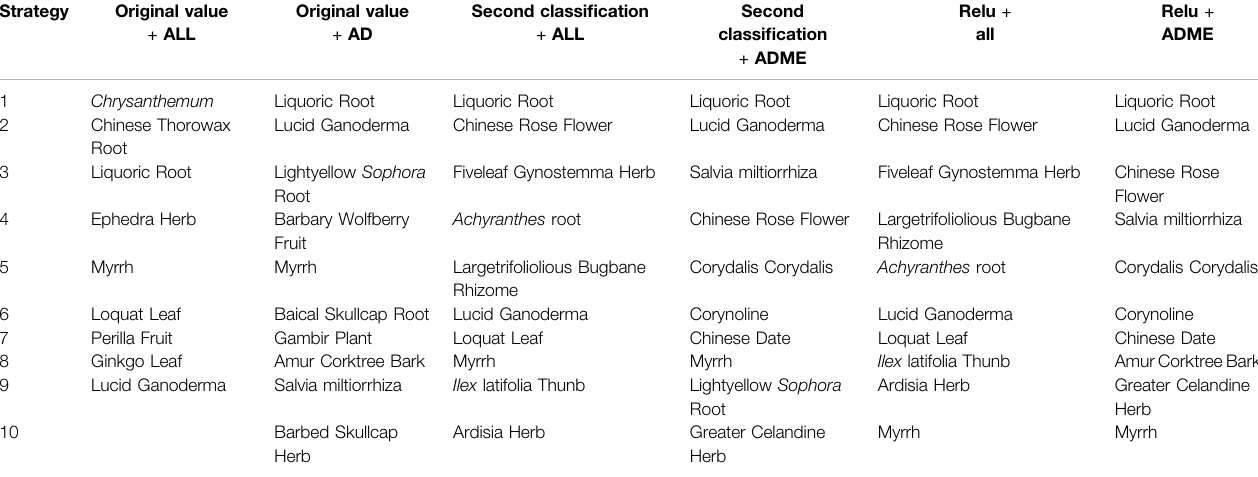
TABLE 3 | Molecular docking results of six different ways of herbal medicine. Strategy